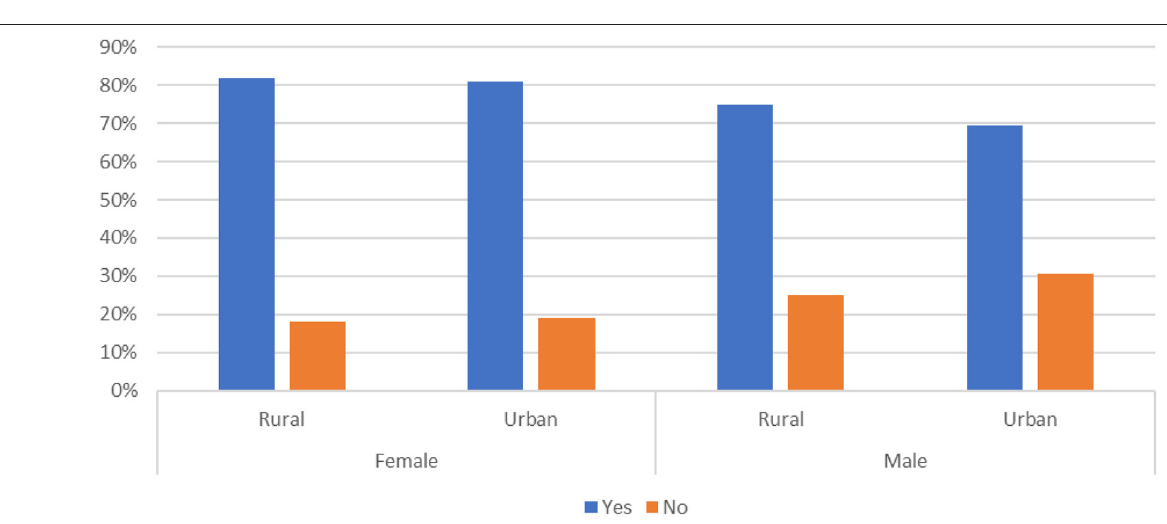
FIGURE 3 | Do you feel renewable energy sources will reduce the cost of